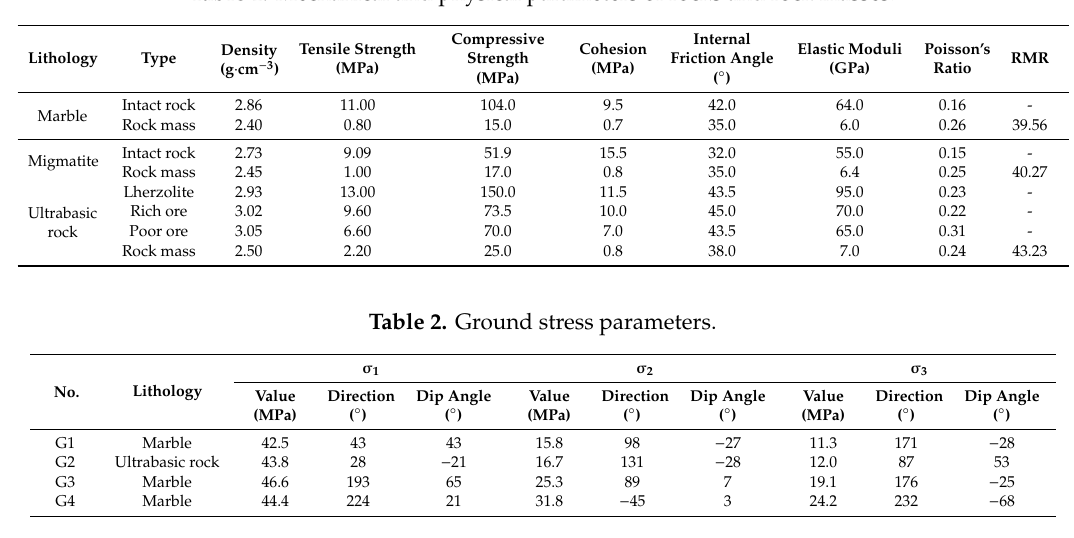
Table 1. Mechanical and physical parameters of rocks and rock masses.